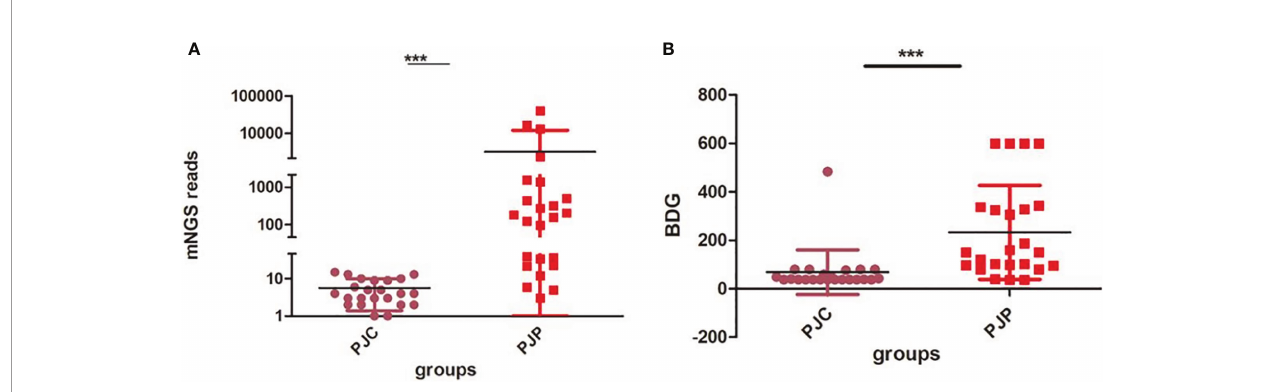
FIGURE 1 | Test of metagenomic next-generation sequencing (mNGS) reads and 1,3- b -D-glucan (BDG) between the Pneumocystis jirovecii pneumonia (PJP) and Pneumocystis jirovecii colonisation (PJC) groups. (A) Test of mNGS reads between the PJP and PJC groups. (B) Test of BDG titre between the PJP and PJC groups ***P